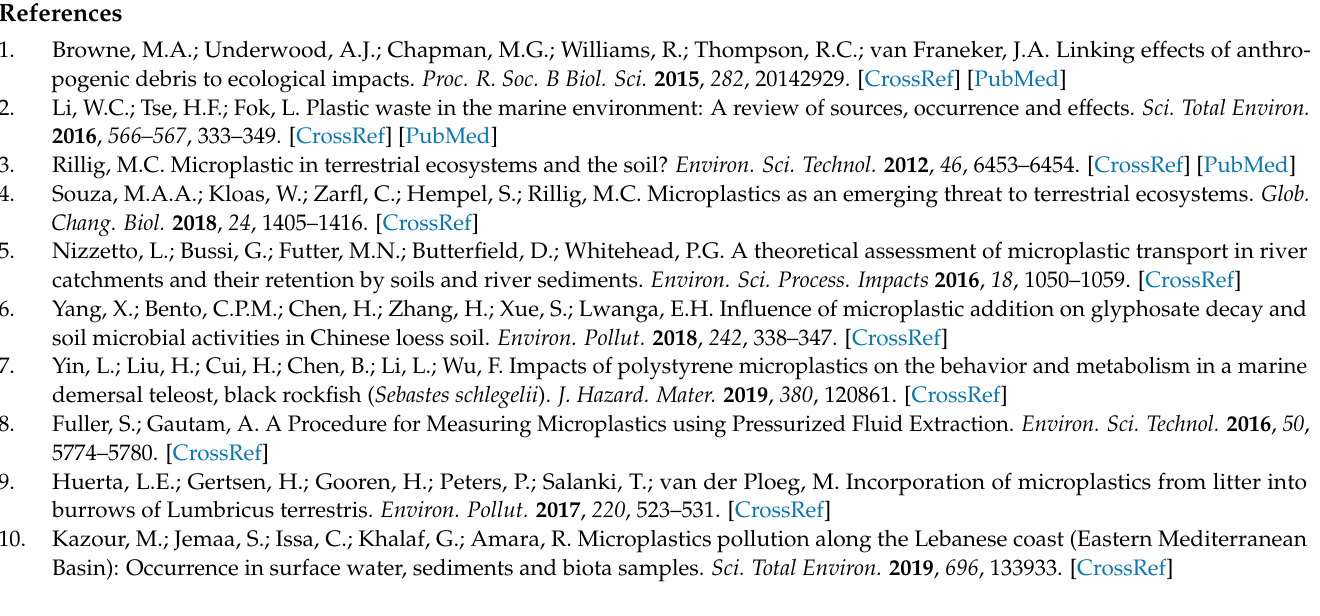
Table S1: The questionnaire information about sampling sites; Table S2: The differences in the abundance of PF in different sampling sites; Table S3: Selection of representative samples in sampling sites; File S1: The code of “forestplot” package in R ver